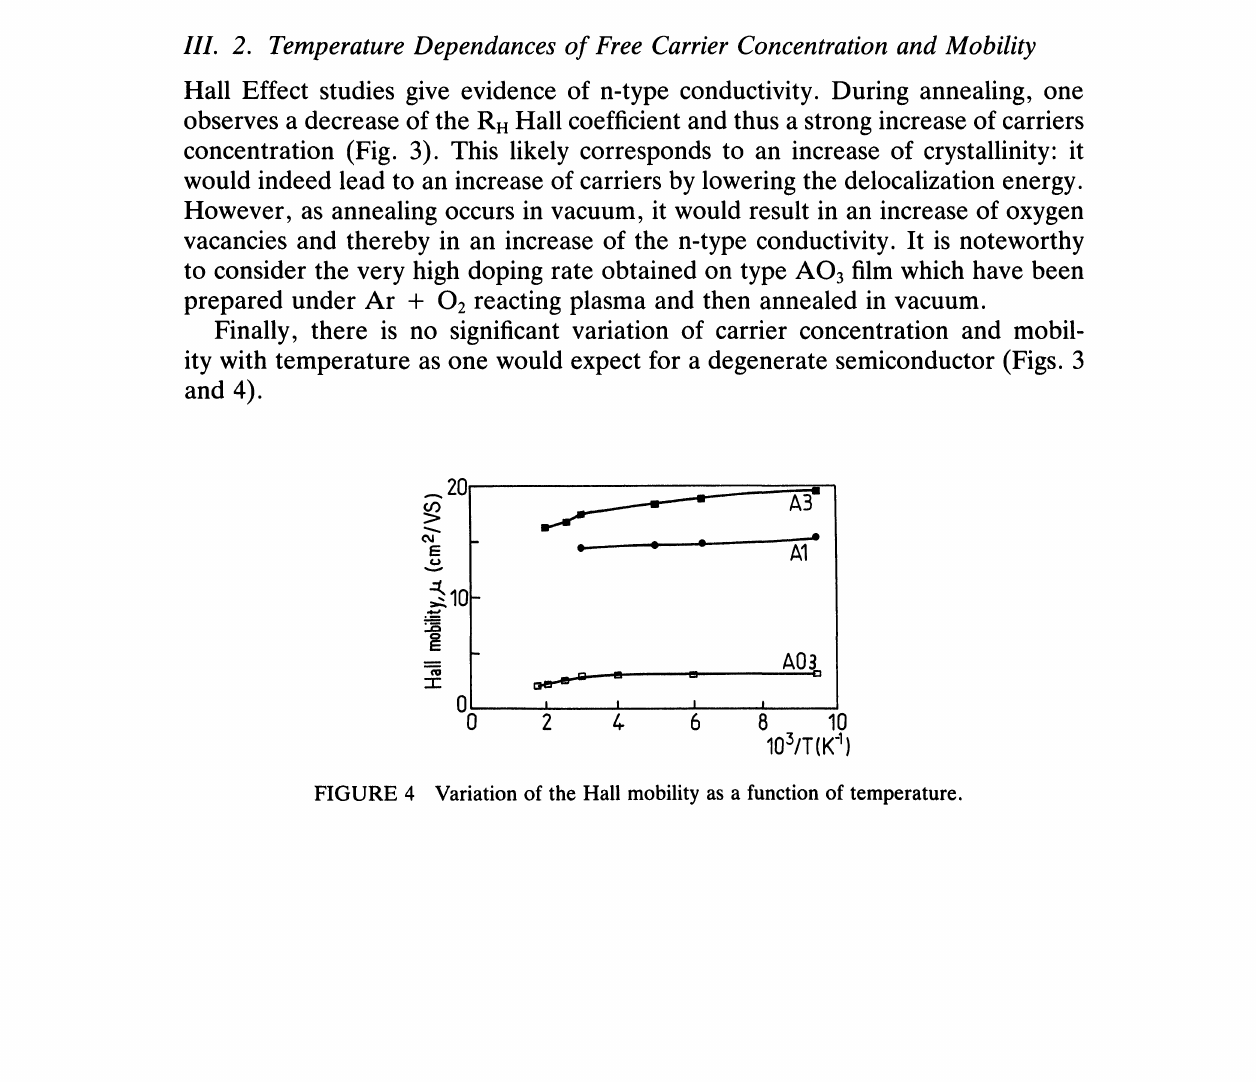
FIGURE 3 Variation of the carrier concentration as a function of temperature.